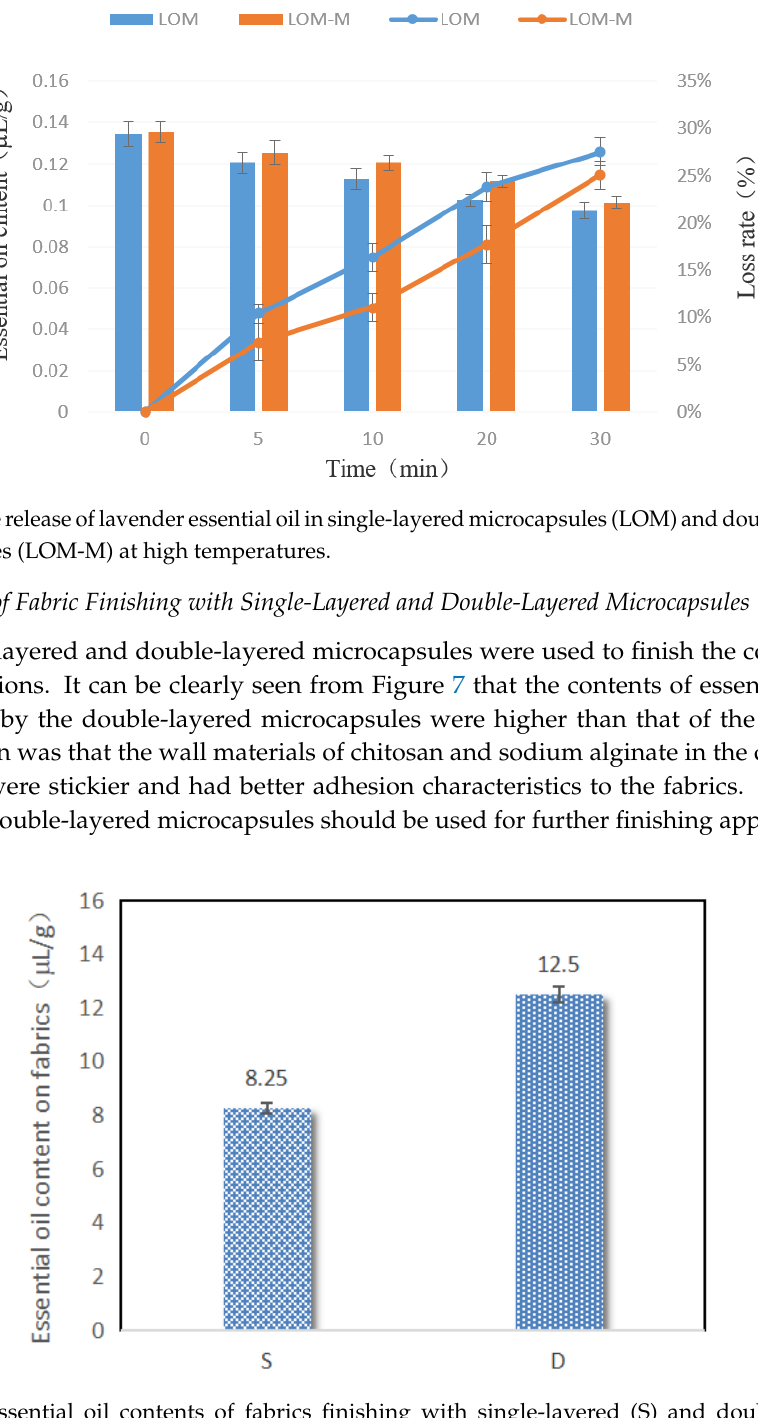
Figure 5. The release of lavender essential oil in single-layered microcapsules (LOM) and double- layered microcapsules (LOM-M) at room temperature.